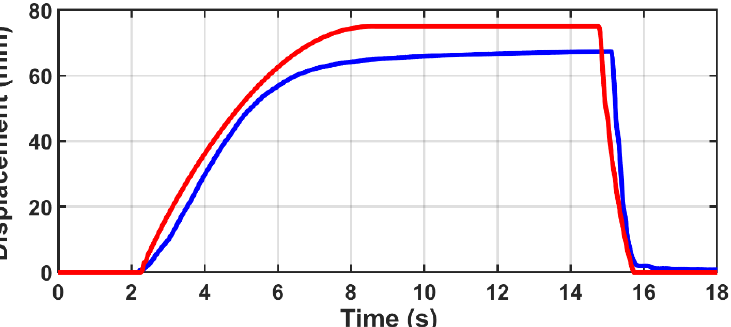
Figure 18. Dynamic responses of the actuator: black line—theoretical results; red line—experimental results for m = 7.5 kg.